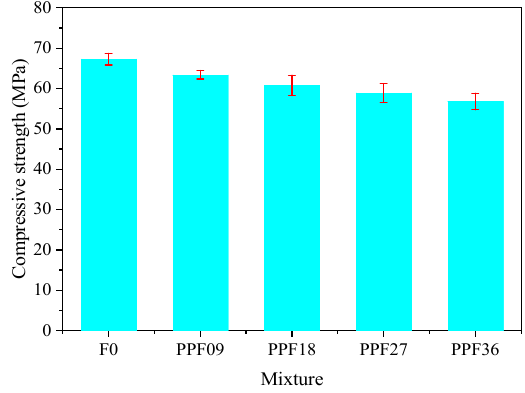
Figure 5. Compressive strength of all mixtures at 28 d.